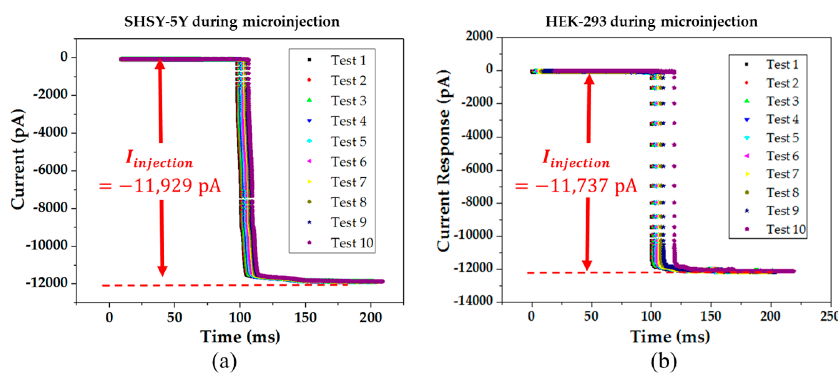
Figure 8. The current response of the cell during the cell cytoplasmic microinjection: (a) the microinjection process of the SHSY-5Y cell with 10 results; (b) the microinjection process of the HEK-293 cell with 10 results.